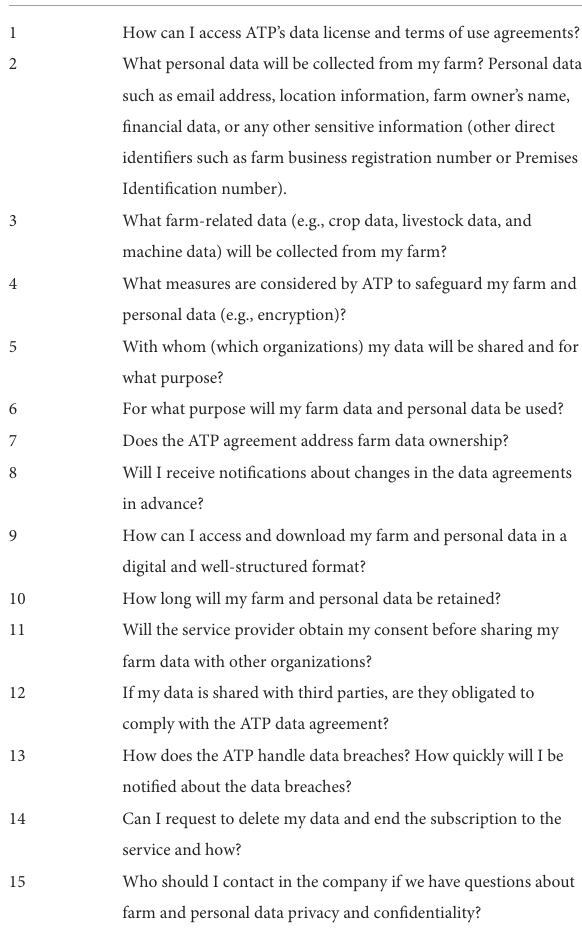
TABLE 1 Questions that farmers can ask ATPs regarding their farm and personal data protection.